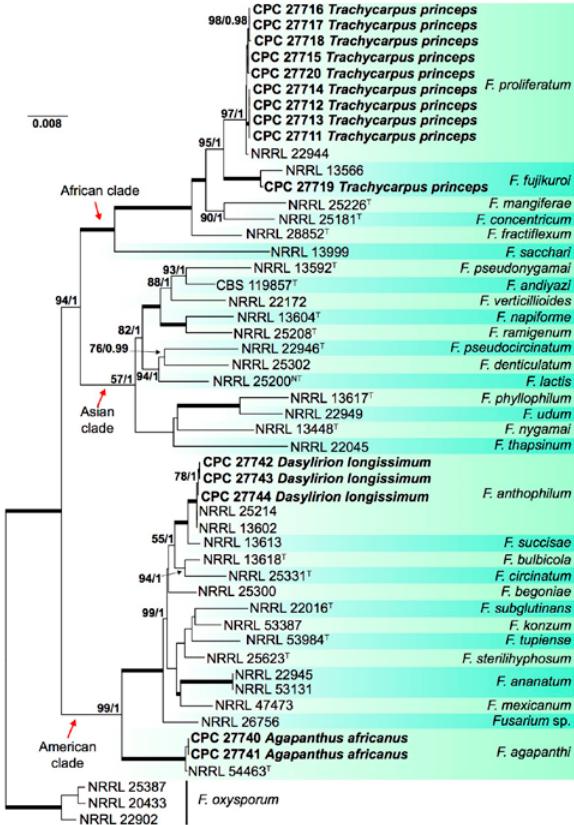
Figure 2. Maximum-likelihood (ML) phylogram of the Fusarium fujikuroi species complex obtained from combined ITS, RPB1 , RPB2 , EF-1α and TUB sequences. Branch lengths are proportional to distance. Numbers on the nodes are ML bootstrap values greater than 55%; and Bayesian posterior probability values greater than 0.95. Full supported branches and isolates obtained from ornamen- tals plants are indicated in bold. Ex-type strains are indicated with T and ex-neotype strains are indicated with NT .